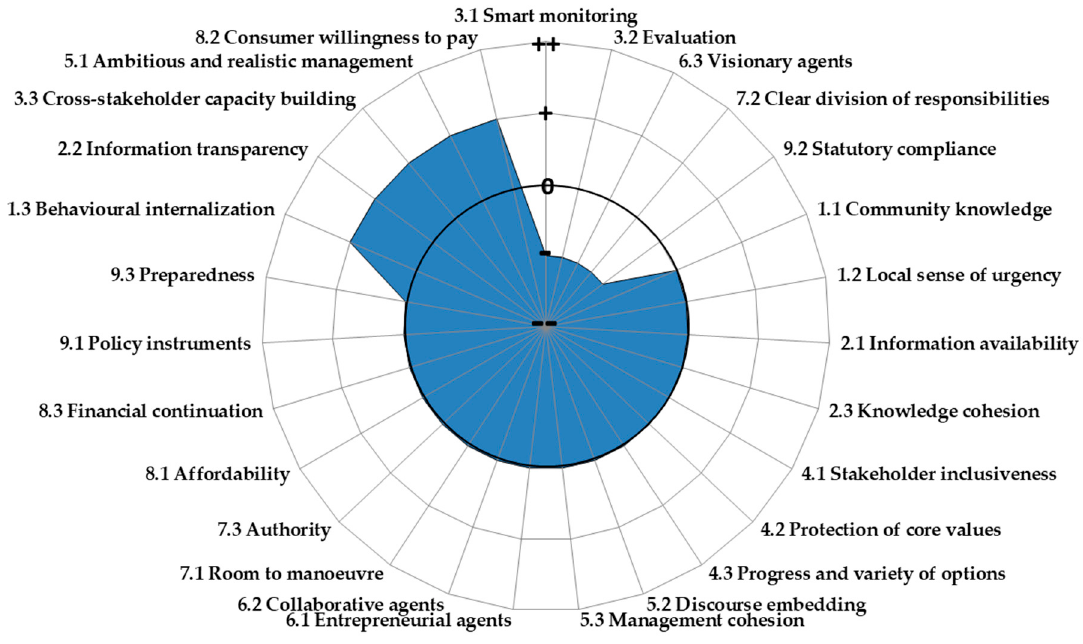
Figure 4. Governance Capacity Framework results for Ulaanbaatar on IWRM.